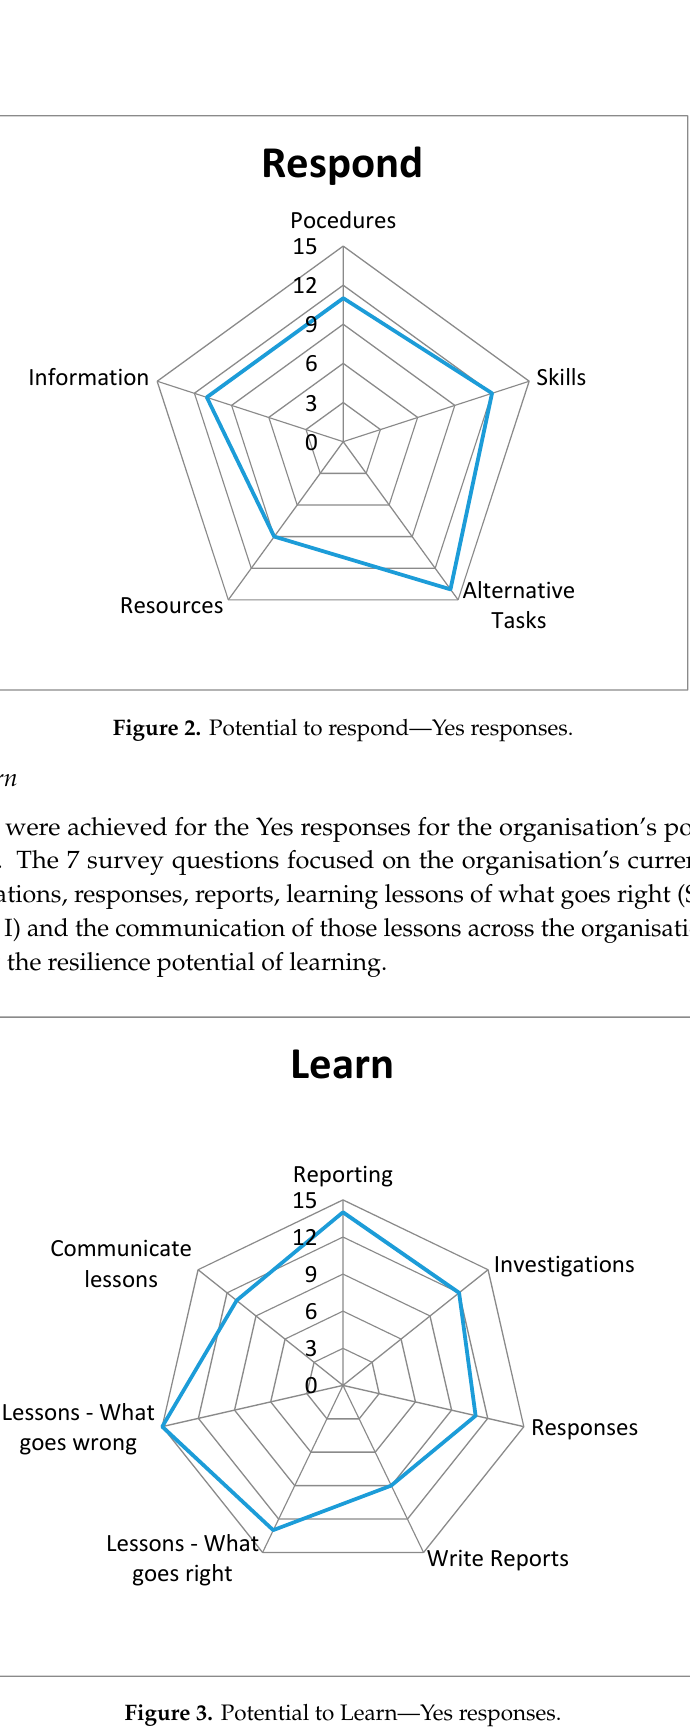
Figure 4. Potential to Monitor—Yes responses. A high percentage (80%) of the participants responded Unknown to the question ‘the period covered by lagging indicators is appropriate’ with only a few Yes responses being given (n = 5). The